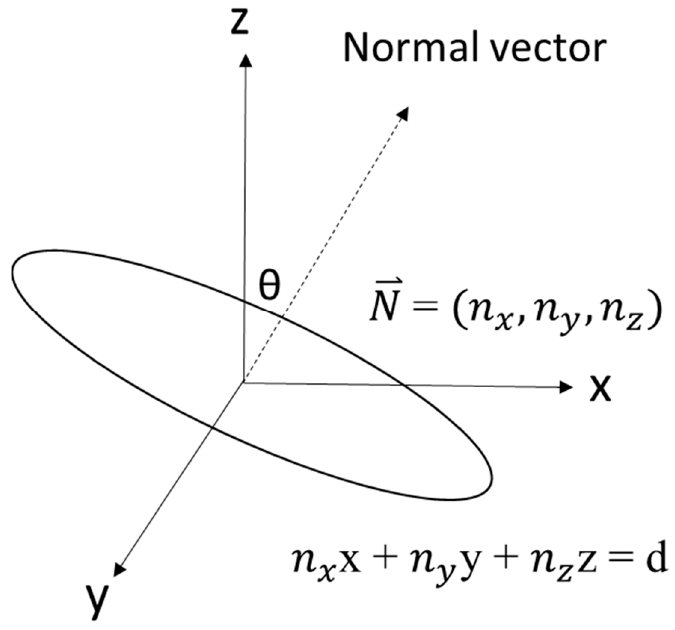
Figure 5. Illustrated definition of leaf angle ( θ ).